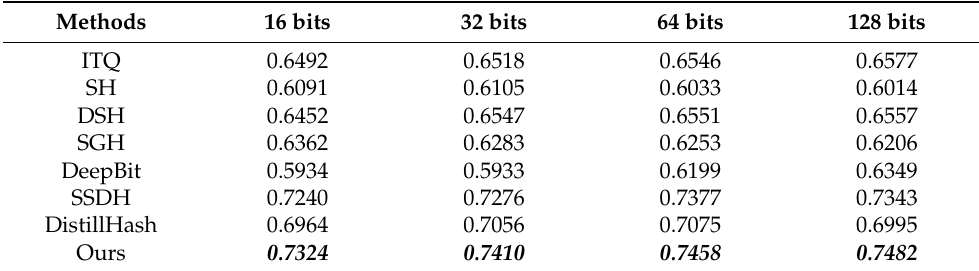
Table 4. mAP with other unsupervised methods on